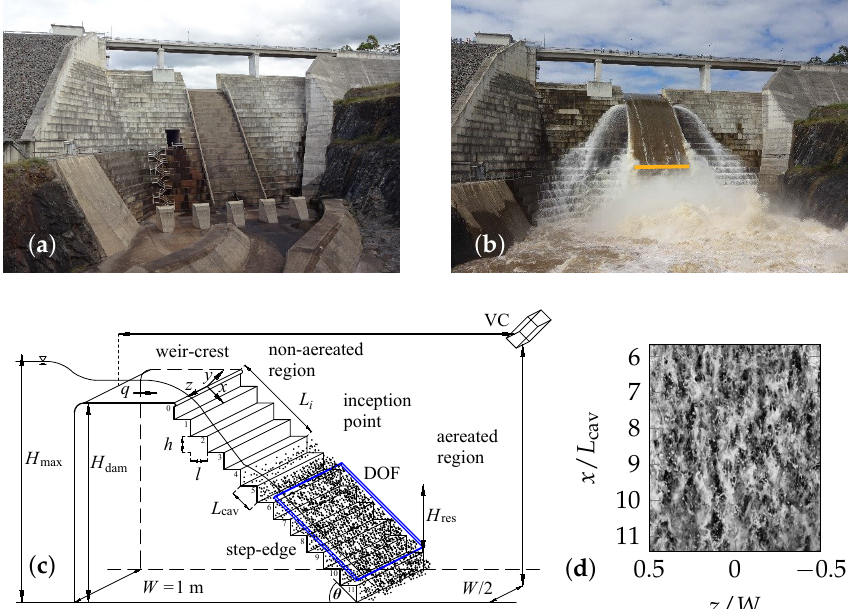
Figure 1. Investigated spillway chutes ( a ) Hinze Dam, Gold Coast, Australia: frontal view of the stepped spillway (third stage) as completed in 2011, ( b ) spill event in March 2017; q w ≈ 17.21 m 2 /s, d c / h = 2.6, Re ≈ 1.72 × 10 7 ; note the visually determined location (orange line) of the inception point of free-surface aeration ( L i ), ( c ) laboratory chute at the University of Queensland: definition sketch of the stepped spillway; H max : total upstream head; H dam : dam height; H res : residual energy; q w : specific water discharge; h : vertical step height; l : step length; W : channel width; θ : spillway slope; x : streamwise direction; y : normal direction; z : transverse direction; L i : inception point location; L cav : cavity length; VC: video camera; note the indicated measurement location of the video camera (blue window) with DOF = depth of field, ( d ) top view high-speed image of the air–water flow down